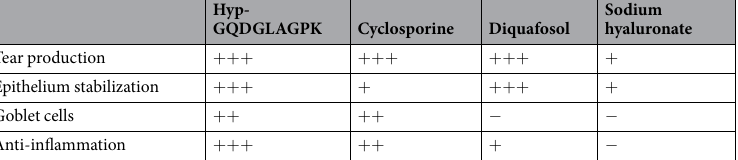
Table 1. Comparing the efficacy of Hyp-GQDGLAGPK and commercial medicines in an experimental dry eye mouse model. The effects of Hyp-GQDGLAGPK and commercial medicines on tear production, epithelium stabilization, goblet cell density, and expression of inflammatory markers associated with dry eye disease are indicated as − , + , ++ and +++ . No effect expressed as − ; + indicated significantly different at DS 10d, but no difference with normal saline; ++ indicated significantly different with DS 10d and normal saline group; +++ indicated similar to baseline.